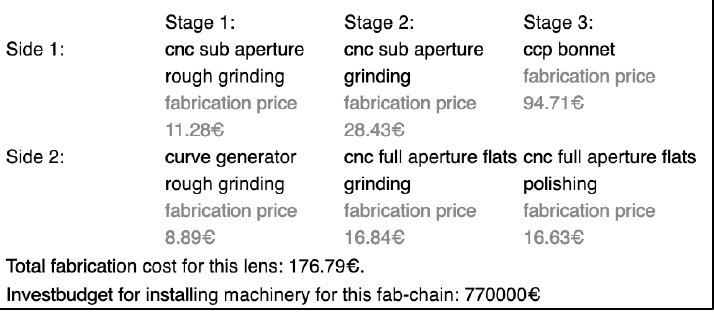
Fig.3. PanDao analysis of the plano-aspherical BK7 lens (Fig.1): reducing lens diameter from 220 mm down to 210 mm gains 4.4 % total fabrication cost reduction.